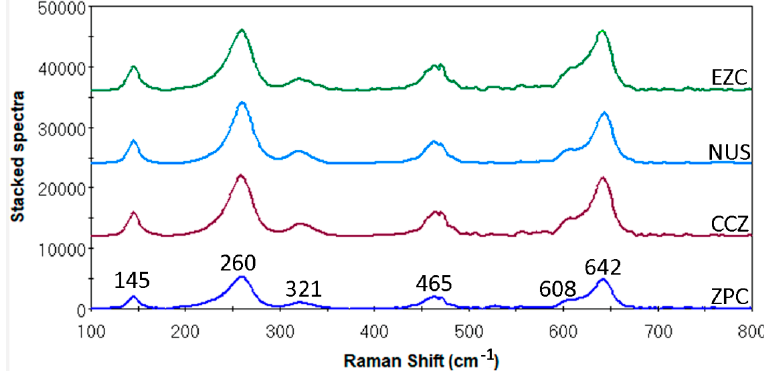
Figure 2. Representative Raman spectra from all tested materials.